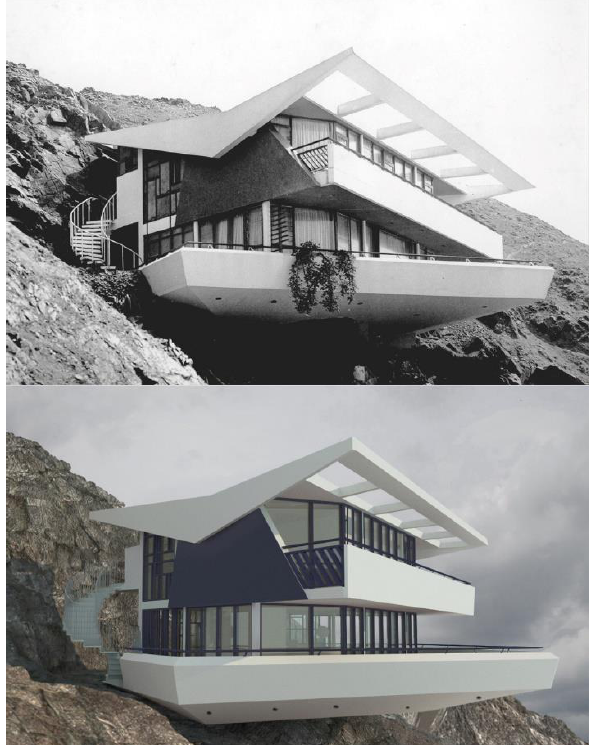
Figure 5. Walter Weberhofer, Fernandini house (1958), Lima. Figure 6. Gama Filgueiras Lima, Residência para Ministro de Estado (1965), Brasília. Axonometric view and interior